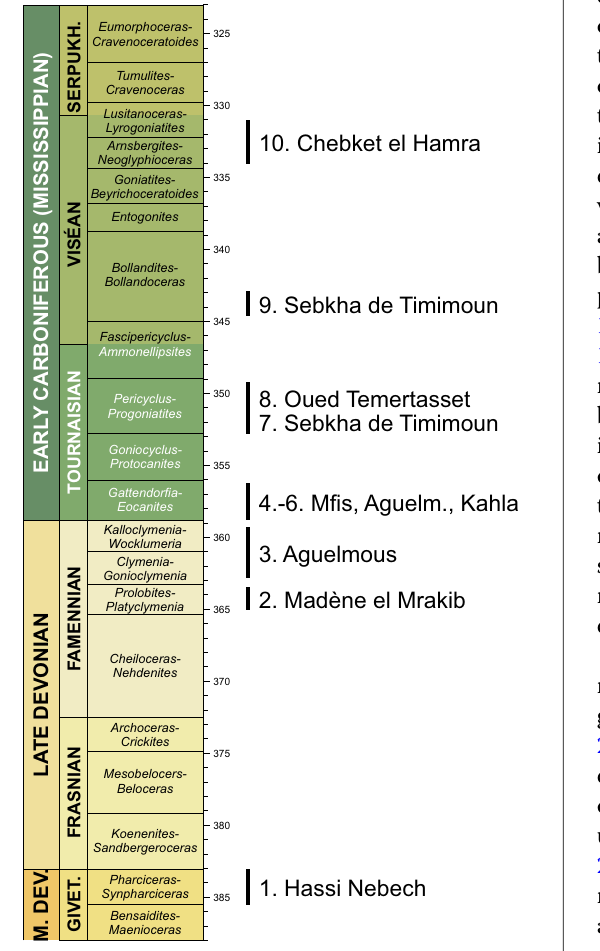
septal crowding is rare to begin with and would also not be picked up if the specimens died before actually showing it.